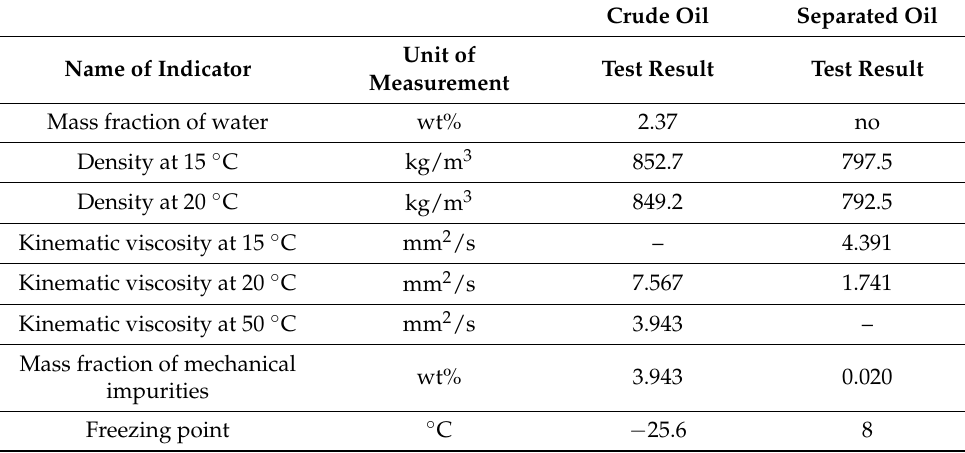
Table 2. Experimentally obtained oil sample